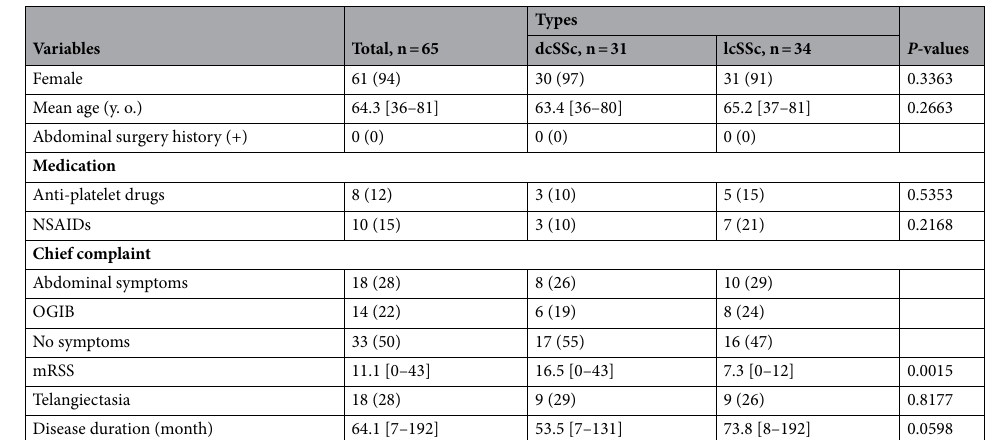
Table 1. Characteristics of patients with systemic sclerosis at the time of capsule endoscopy. Patients were stratified according to the SSc subclassification. Data are shown as frequencies (percentages) or means, as appropriate. SSc: systemic sclerosis, dcSSc: diffuse cutaneous SSc, lcSSc: limited cutaneous SSc, NSAIDs: non- steroidal anti-inflammatory drug, OGIB: obscure gastrointestinal bleeding, mRSS: modified Rodnan’s total skin thickness score.